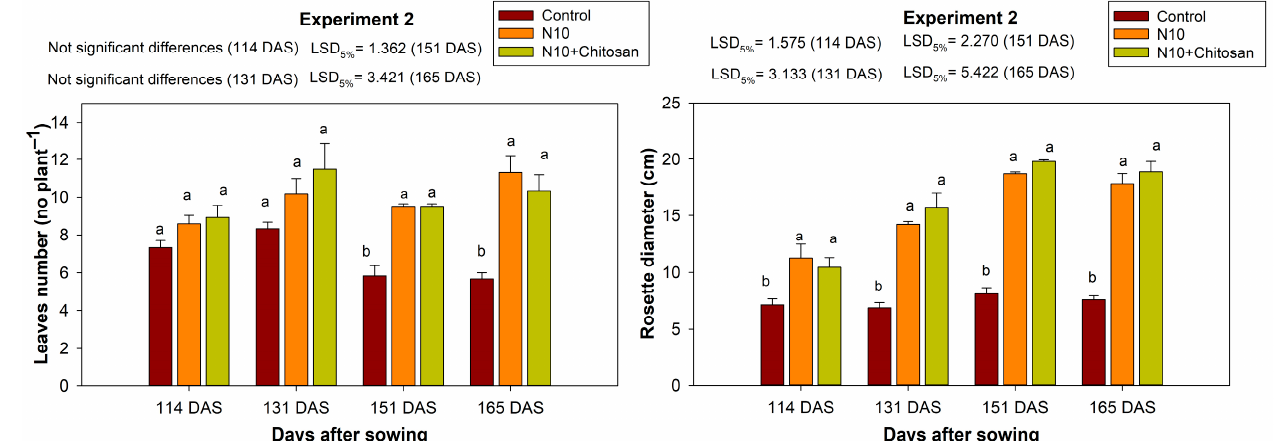
Figure 6. Leaf number (no plant − 1 ) and rosette diameter (cm) of bristly oxtongue as affected by nitrogen fertilization and chitosan application. For each sampling date, bars followed by the same letters were not shown to significantly differ with the Fisher’s least significant difference (LSD) test. Errors bars show the Standard Error values. Final measurement (source of variation: treatments): Leaf number: Fvalue = 12.049, p = 0.020, DF (degrees of freedom) = 2 and Rosette diameter: Fvalue = 20.673, p = 0.008, DF = 2.